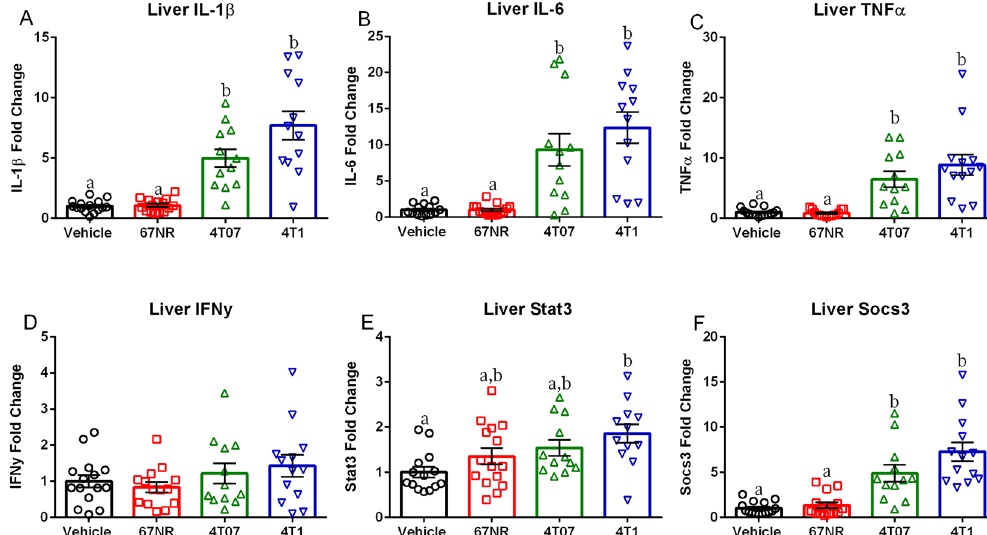
Figure 3. 4T07 and 4T1 Tumors Increase Liver Inflammation and Downstream IL-6 Signaling. ( A – D ) Liver cytokine mRNA expression of IL-1 β , IL-6, TNF α , and IFN γ expressed as fold change from vehicle.( A – C ) Liver IL-1 β , IL-6, and TNF α were significantly increased in 4T07 and 4T1 tumors relative to 67NR tumors and vehicles. ( D ) There were no significant differences in liver IFN γ . ( E–F ) mRNA levels of downstream IL-6 signaling molecules, STAT3 and SOCS3 expressed as fold change from vehicle. ( E ) STAT3 mRNA expression was increased in 4T1 tumors relative to vehicles. ( F ) Liver Socs3 mRNA was significantly higher in 4T07 and 4T1 tumors relative to 67NR tumors and vehicles. The measures and tissues were collected 20 days after tumor cell or vehicle inoculation (n = 12–15/group). The data are presented as mean + SEM. Graph bars that do not share a letter are statistically significant different at p <